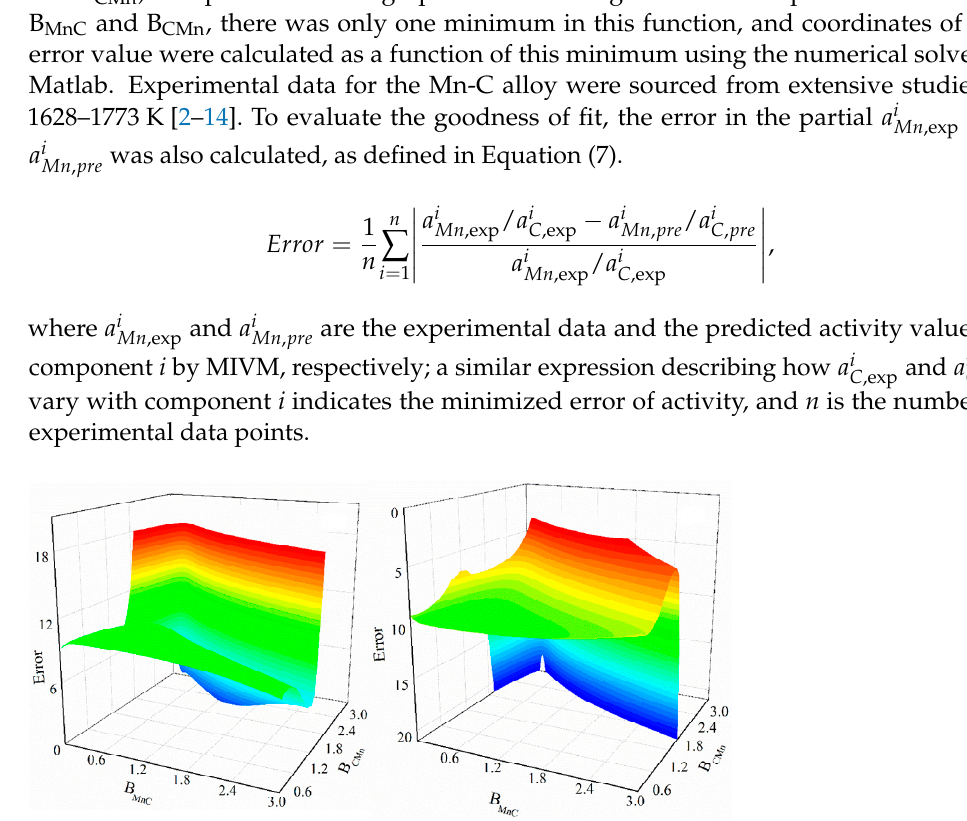
Figure 1. Representative case of error as a function of B MnC and B CMn in the case of Mn–C liquid alloy at 1772 K (minimum obtained for B MnC = 1.780 and for B CMn = 1.343).